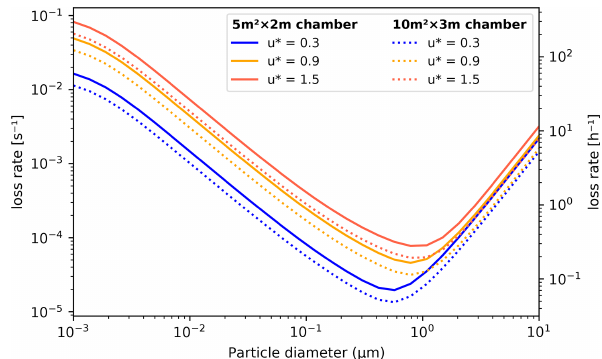
Figure 5. Particle loss rates as a function of particle diameter, fric- tion velocity and chamber volume (given as floor area × height) as calculated by the aerosol loss rate parametrization. The rates are calculated at room temperature (20 ◦ C) and pressure